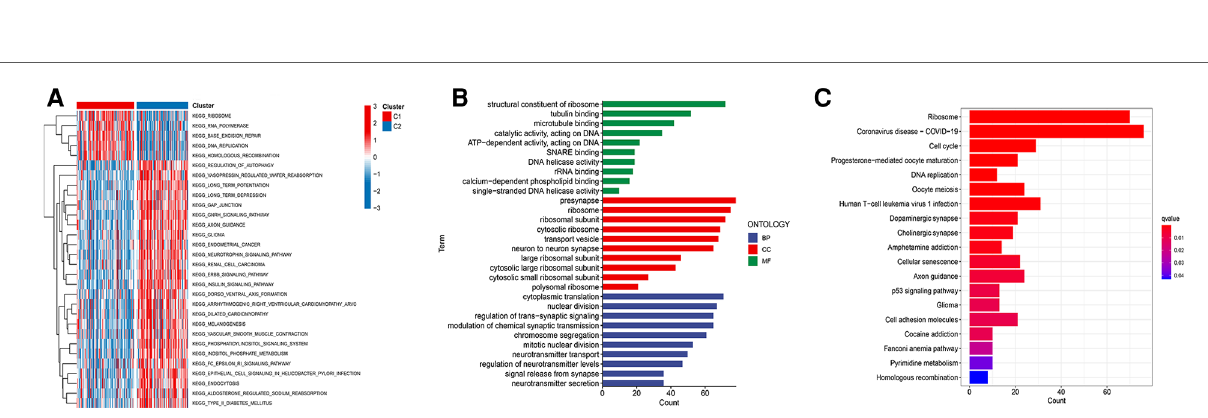
FIGURE 2 Two distinct ferroptosis subtypes were obtained from the training set based on FRGs. ( A ) The NMF clustering results when consensus matrix, k =2. ( B ) The PCA scatter plot of two subtypes. ( C ) Kaplan-Meier curves of two ferroptosis subtypes in 144 patients from the training set. Log-rank test, p <0.001. ( D ) Heatmap of the differences in FRGs expression and clinicopathological parameters between the two subtypes. ( E ) The abundance of different immune in fi ltrating cells in different subtypes.